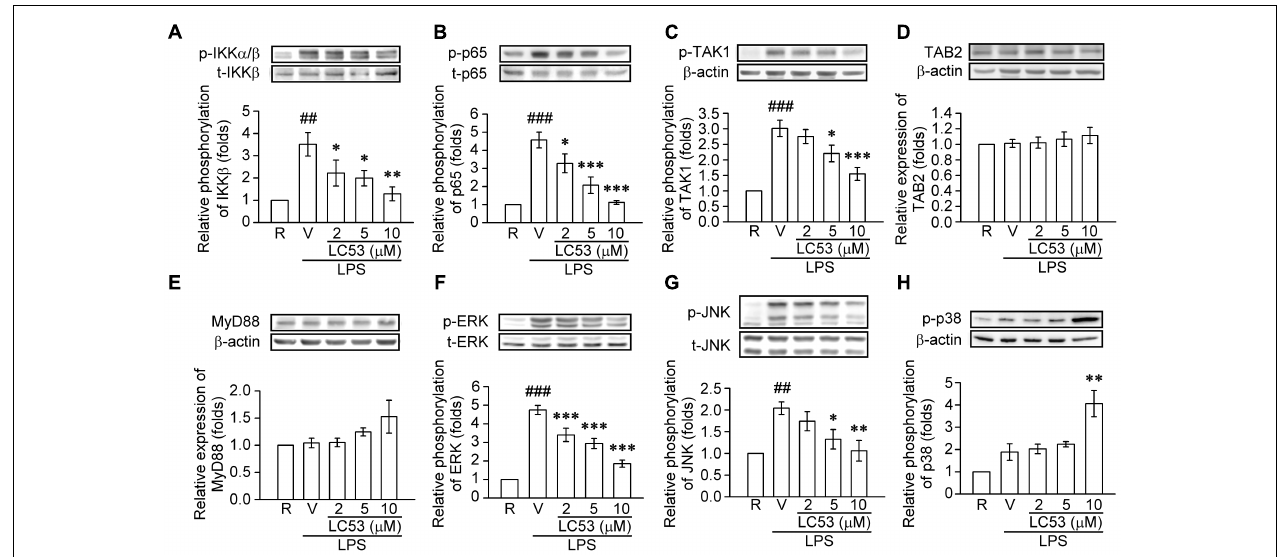
FIGURE 6 | LC53 abrogated the NF κ B and MAPKs signaling in LPS-stimulated microglial BV2 cells. Microglial BV2 cells were pretreated with the vehicle (DMSO) or LC53 (2, 5, and 10 µ M) and stimulated with LPS (150 ng/ml) for indicated time. Phosphorylated level of IKK α / β ( A , n = 4), p65 ( B , n = 4), TAK1 ( C , n = 6), ERK ( F , n = 7), JNK ( G , n = 5), and p38 ( H , n = 4), and protein level of TAB2 ( D , n = 7) and MyD88 ( E , n = 3) in cell lysates were examined using Western blot. R, resting; V, vehicle (DMSO). ## p < 0.01, ### p < 0.001 compared with the resting group; ∗ p < 0.05, ∗∗ p < 0.01, ∗∗∗ p < 0.001 compared with the LPS-stimulated group treated with